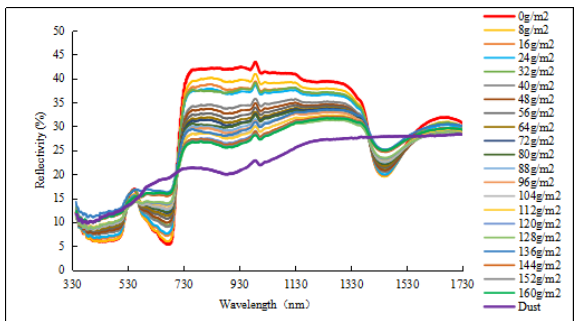
Fig. 1. Leaf reflectivity curve varies with dustfall